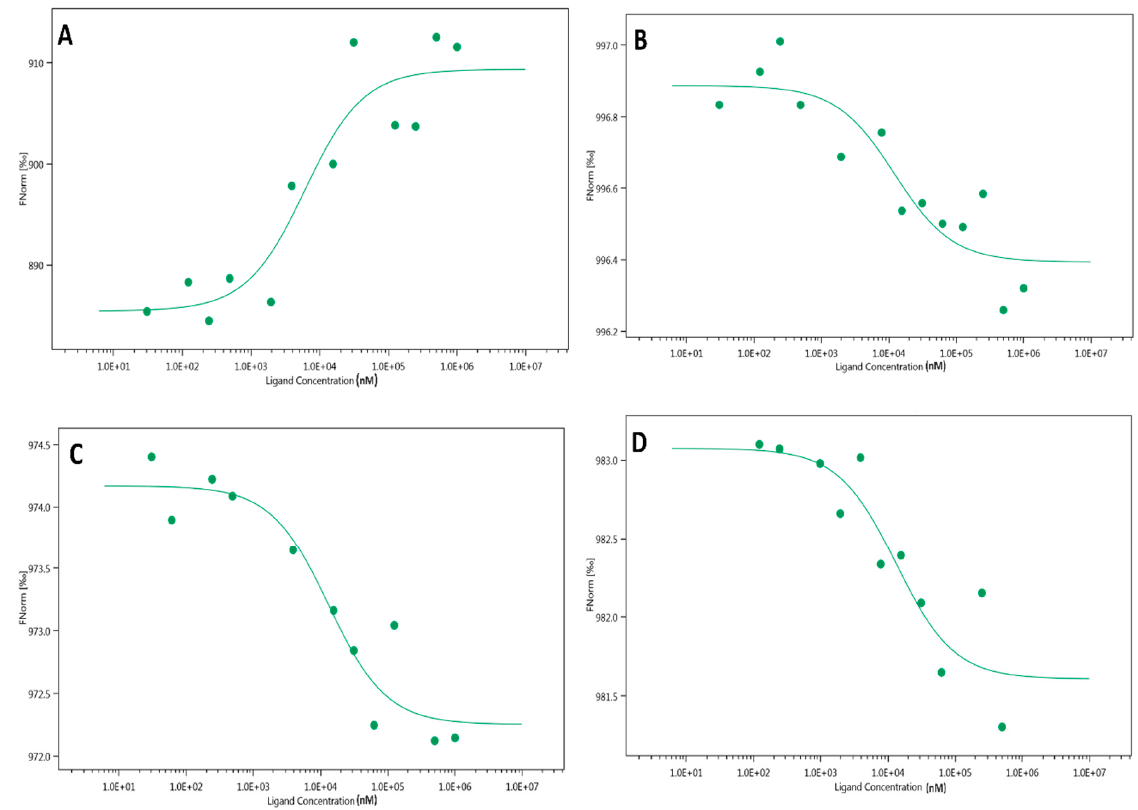
Figure 3. MST analysis of the interaction between artificial sweeteners and the LasR protein. ( A ) 3-oxo-C12-HSL binds LasR with a K d of 5823.3 ± 4.17 nM. ( B ) aspartame binds LasR with a K d of 11,845 ± 0.11 nM. ( C ) Sucralose binds LasR with a K d of 12,835 ± 0.29 nM ( D ) saccharin binds LasR with a K d of 12,896 ± 0.27 nM.